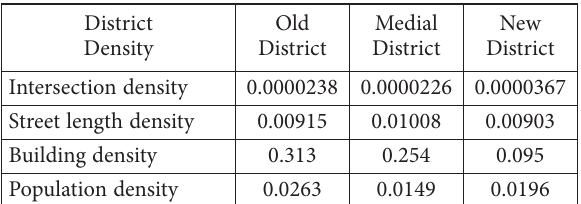
districts (source: authors) District Density